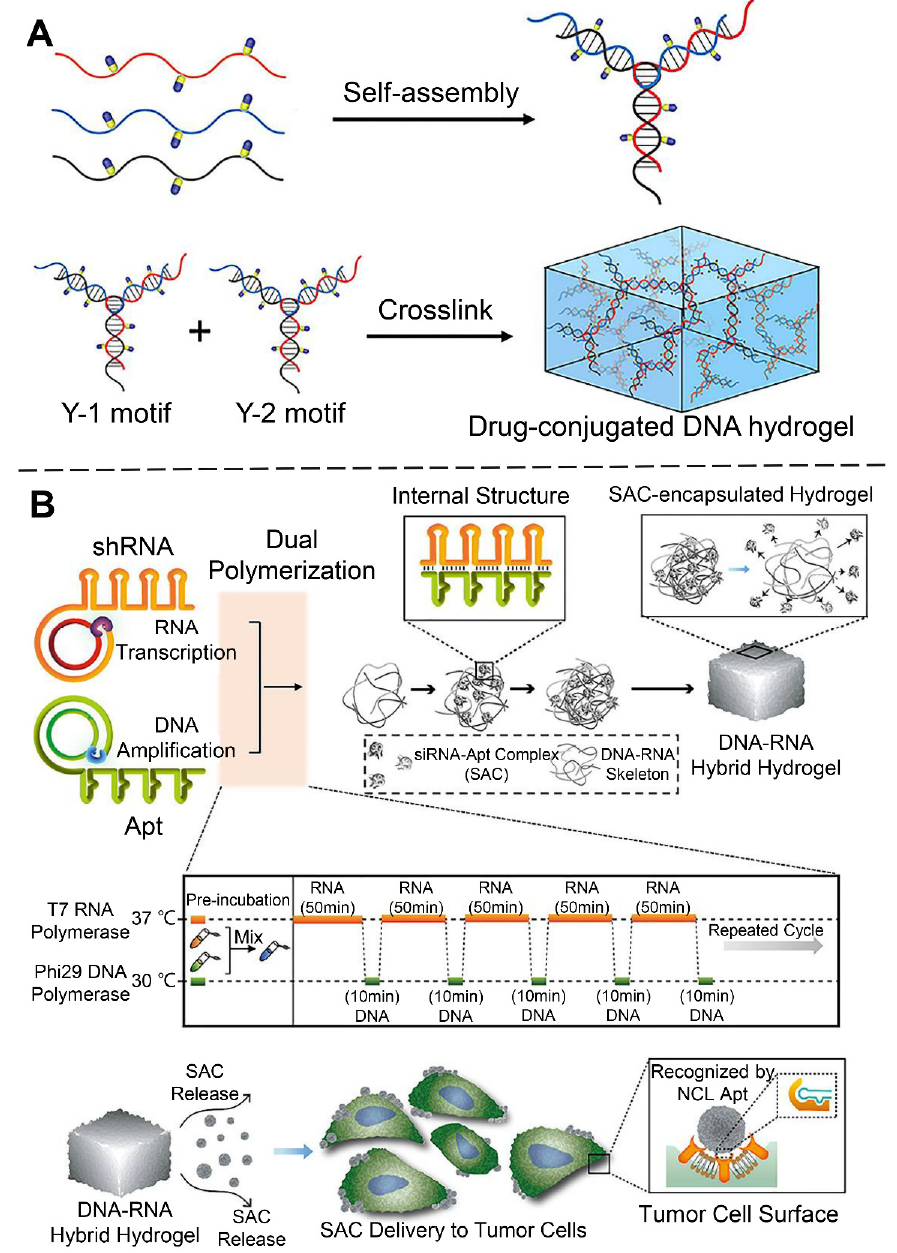
Figure 2. Application of DNA hydrogels in antitumor drug delivery. ( A ) DNA hydrogels grafted with camptothecin (CPT) on the DNA backbone were used for topical chemotherapy. (Adapted with permission from [60]. Copyright (2020) American Chemical Society.) ( B ) DNA-RNA hybrid hydrogel synthesized by dual polymerization process for tumor-targeted delivery of SAC. (Adapted with permission from [66]. Copyright (2021) American Chemical Society.)